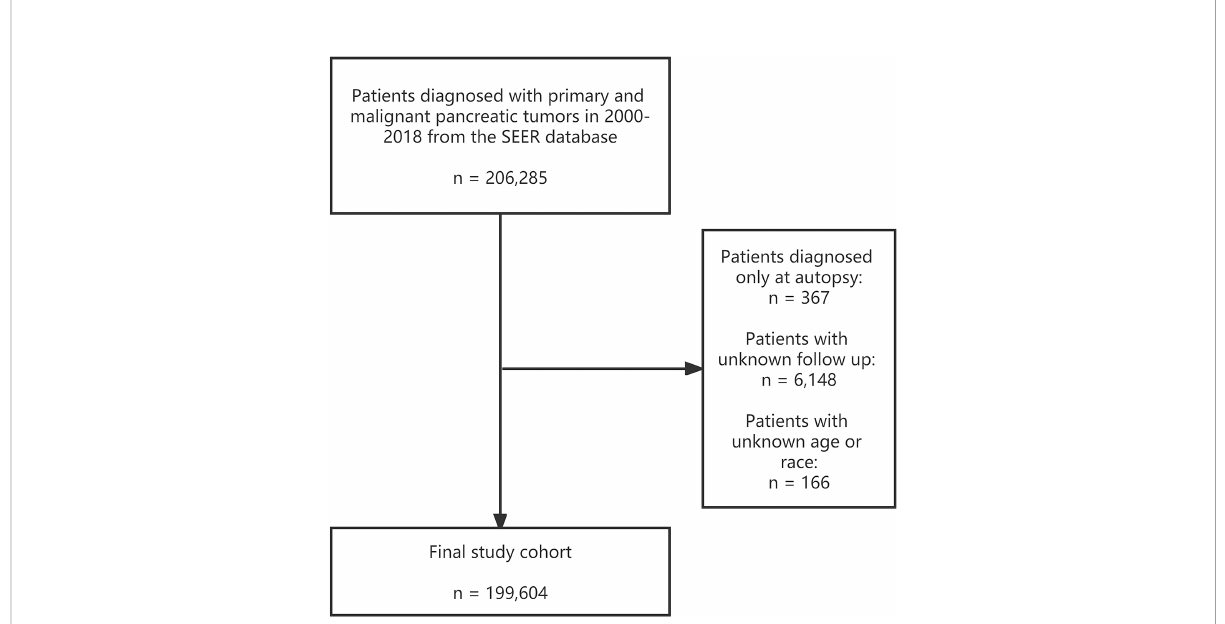
FIGURE 1 Screening process of 199,604 patients diagnosed with primary and malignant pancreatic tumors in 2000-2018 in the SEER database. SEER: Surveillance, Epidemiology, and End Results